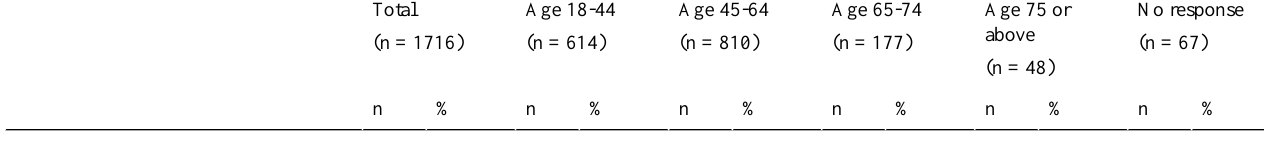
No response 67)Age 75 or (n =